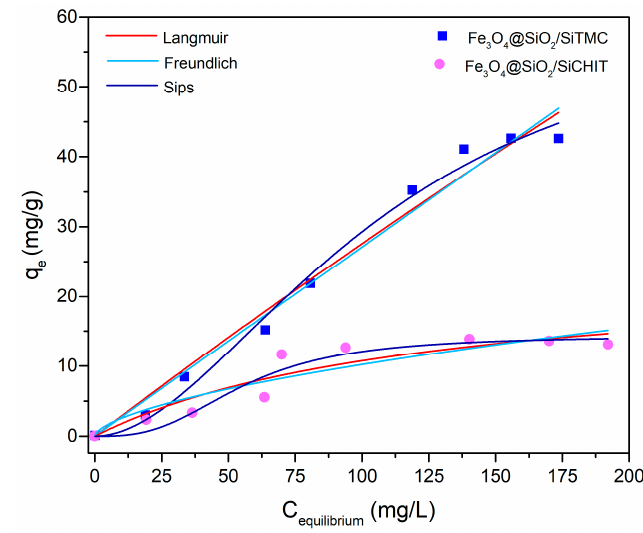
Figure 8. Isotherm data for the adsorption of sulfamethoxazole on Fe 3 O 4 @SiO 2 /SiTMC and Fe 3 O 4 @SiO 2 /SiCHIT particles, and model fitting. Table 2. Equilibrium model parameters obtained from model fitting to experimental sorption data of